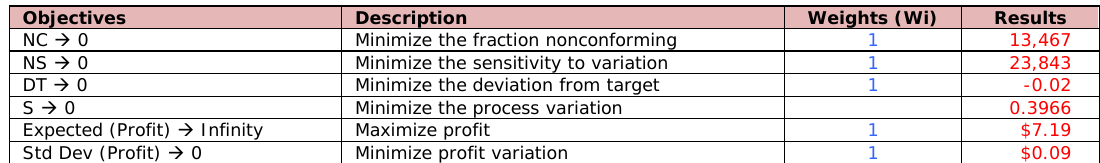
Table 2. “Expected performance of the process in its initial state”.